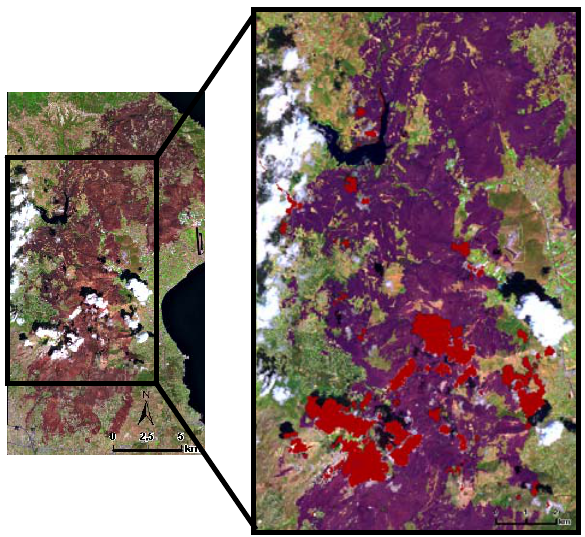
Figure 3. Optical and radar classification of the burned areas in